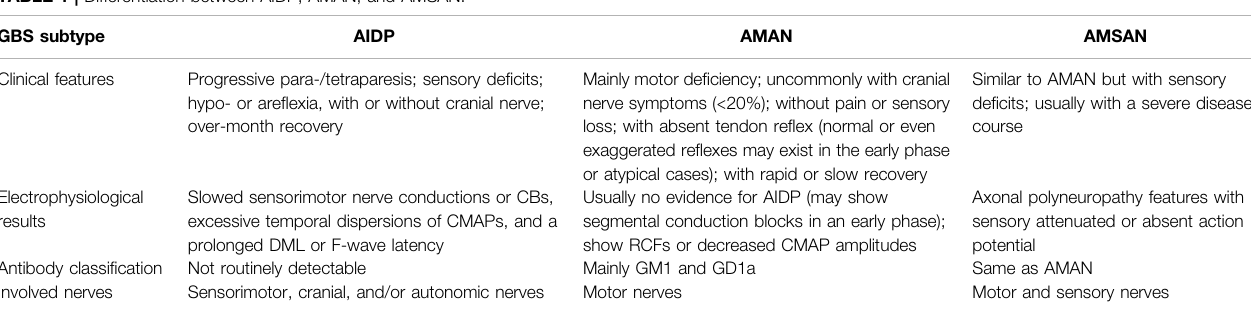
TABLE 1 | Differentiation between AIDP, AMAN, and AMSAN. GBS subtype Clinical